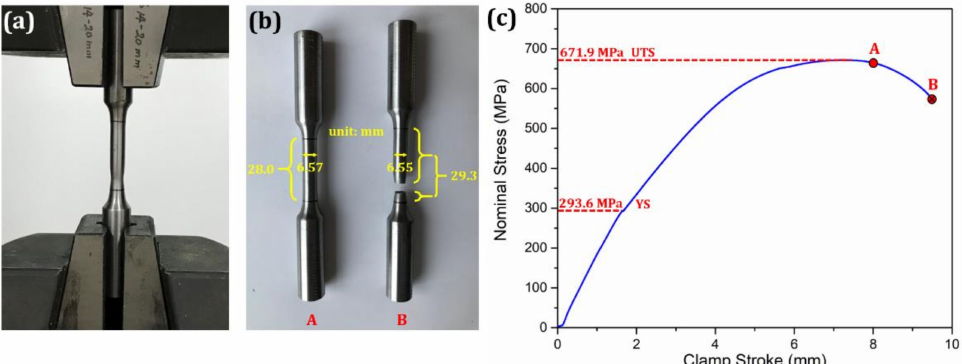
Figure 2. ( a ) Tensile mechanical tests, ( b ) interrupted Specimen A and ruptured Specimen B, as well as ( c ) nominal stress–clamp stroke curve obtained from tensile mechanical tests.